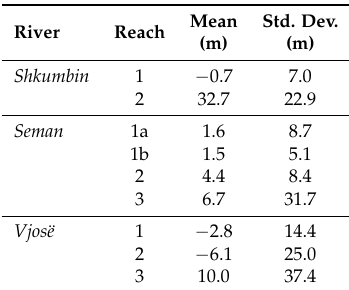
Table 4. Mean and standard deviation of the differences between the active channel widths obtained from the applied procedure and from the reference